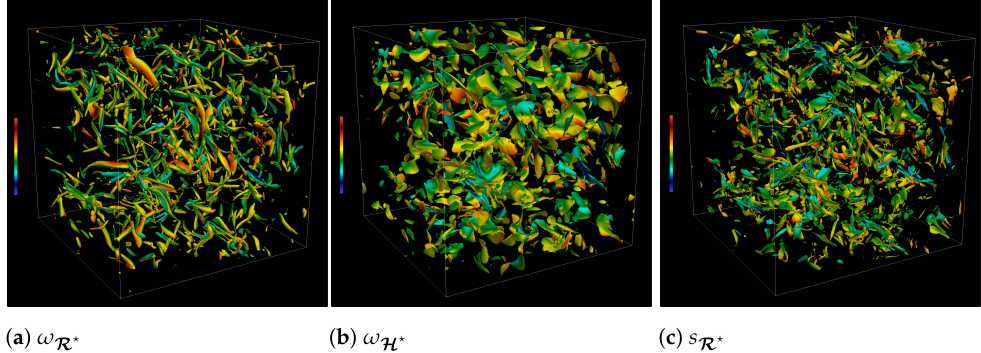
Figure 6. Three-dimensional visualization of isosurfaces of ω R (cid:63) , ω H (cid:63) , and s R (cid:63) for Ma t = 0.5.